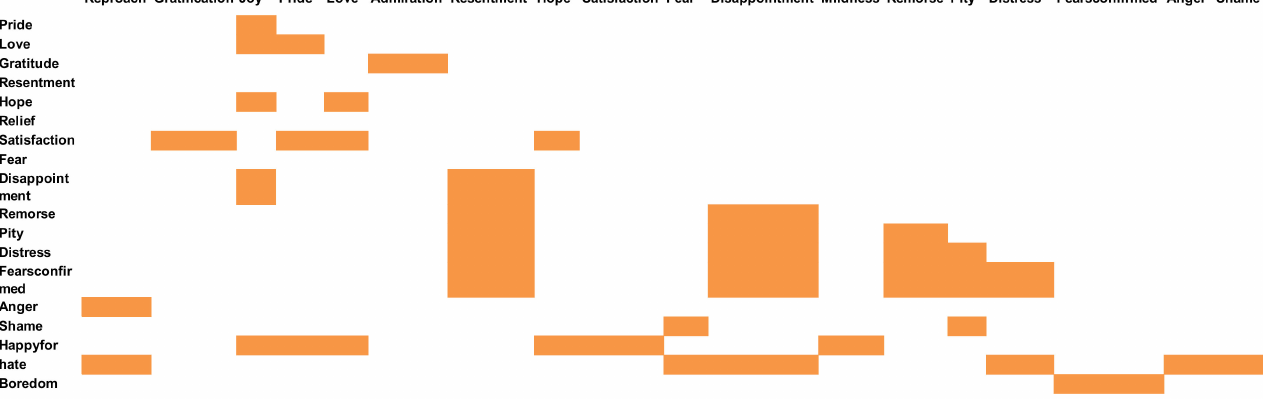
Figure 1. Relevance of emotion words in the three dimensions of PAD. Table 1. Coordinate values of 20 emotion words in PAD three-dimension emotion